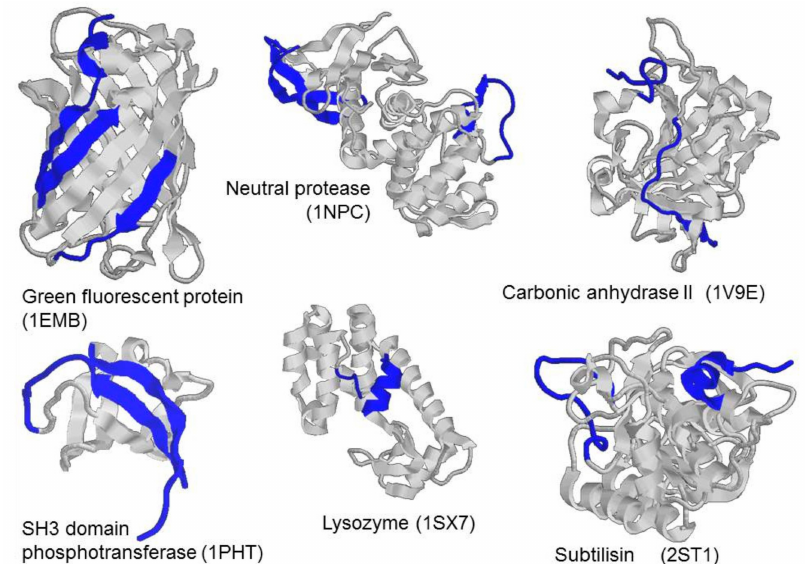
Figure 1. Three-dimensional (3D) structures of green fluorescent protein (1EMB), neutral protease (1NPC), carbonic anhydrase (1V9E), SH3 domain phosphotransferase (1PHT), lysozyme (1SX7), subtilisin (2ST1). Blue color highlights regions predicted by PONDR ® FIT program as intrinsically